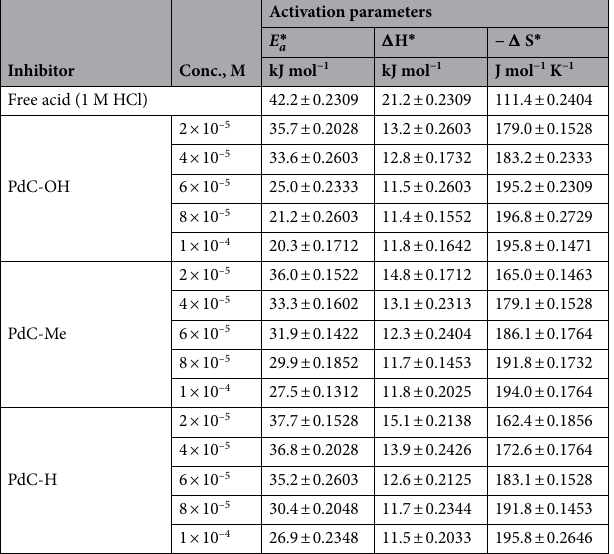
Table 6. Activation parameters for the corrosion of carbon steel in the absence and presence various molar concentrations of PdC-OH, PdC-Me and PdC-H compounds in 1 M HCl.